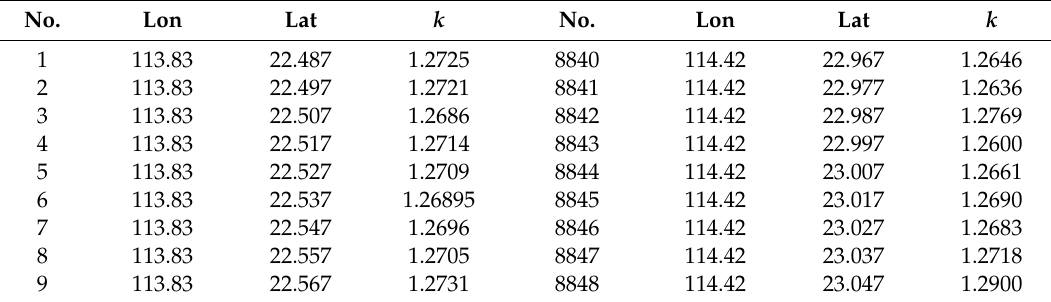
Table 4. Partial results of correction coe ffi